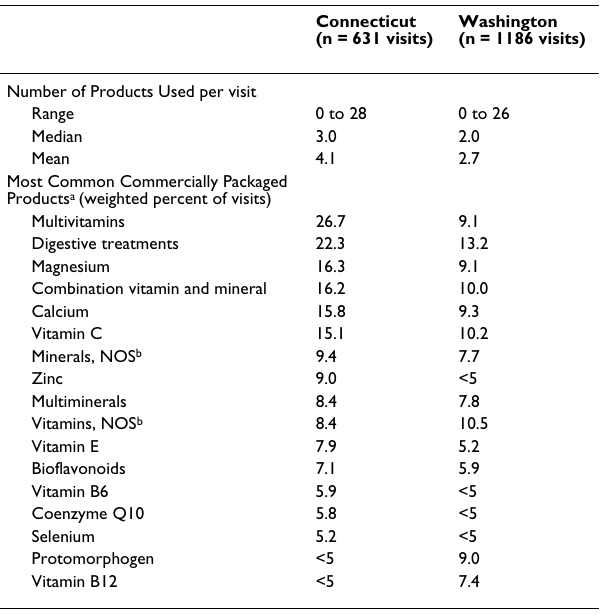
Table 6: Most common commercially packaged products used by naturopathic practitionersin Connecticut (1998) and Washington (1999)